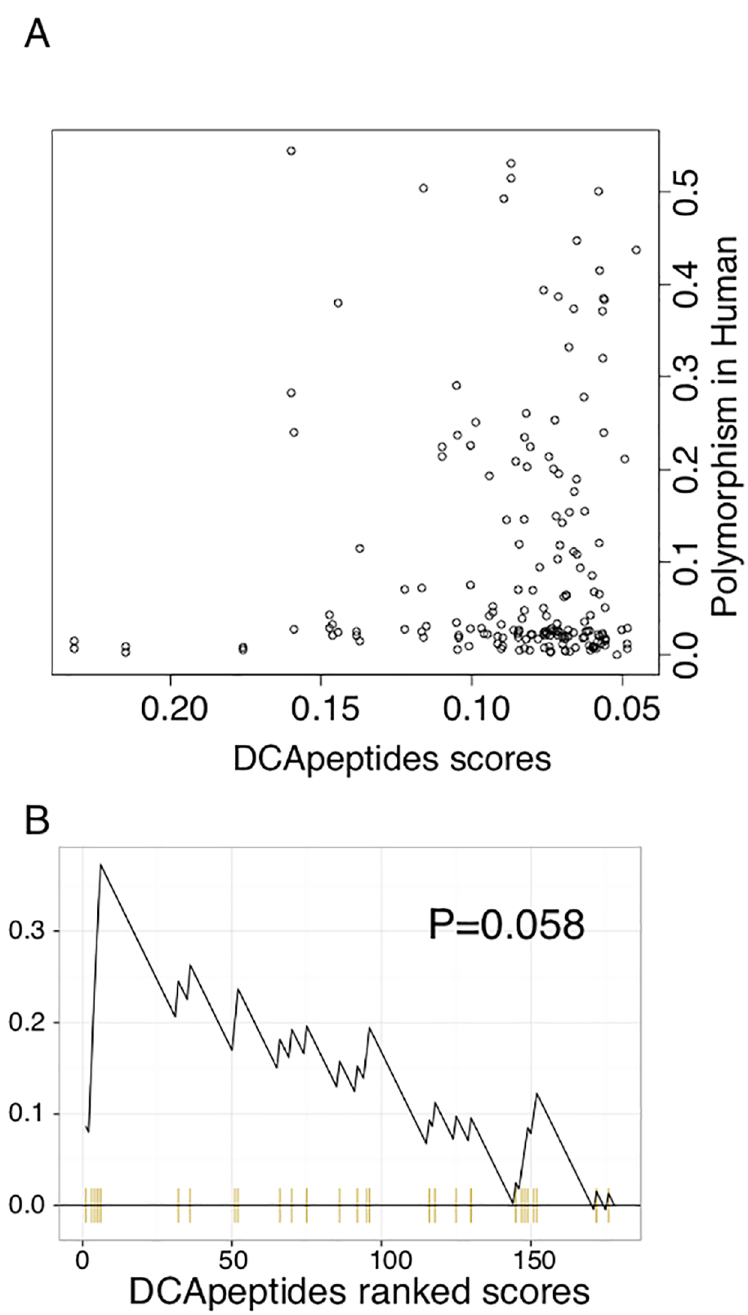
Fig 4. Co-evolution in the presence of peptides. A. Relationship between DCA scores and the polymorphism score when including predicted MHC-I ligands in the alignment and using the extended version of DCA (“DCApeptides”). The x-axis denotes the polymorphism score and the y-axis denotes DCApeptides co-evolution score (see Materials and Methods). B. Enrichment in non-polymorphic sites (threshold of 0.01) with respect to DCApeptides